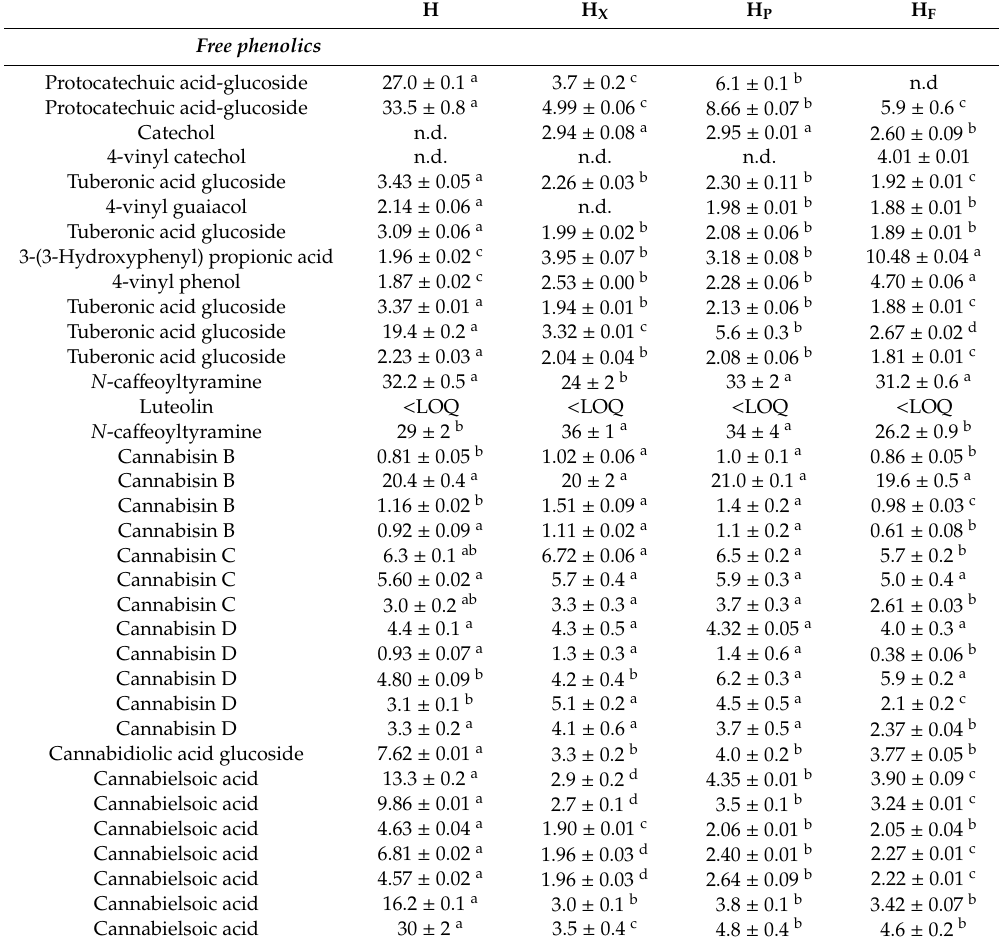
Table 4. Quantification ( µ g / g d.w.) of the phenolic compounds identified in raw and bioprocessed hemp. H, untreated hemp dough; H X , hemp dough treated with xylanase Depol 761P (1% wt / wt of fiber); H P , hemp dough treated with protease VeronPS (2.5% wt / wt of protein); H F , hemp dough fermented by Lactiplantibacillus plantarum 18S9 and Leuconostoc mesenteroides 12MM1 (ratio 1:1, final cell density of circa 7 log10 cfu / g). All treated samples were incubated at 30 ◦ C for 24